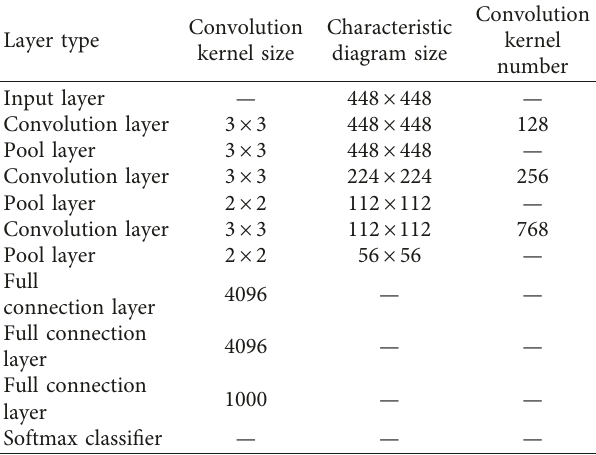
Figure 7: Schematic diagram of AlexNet network model structure. Table 1: The network structure of